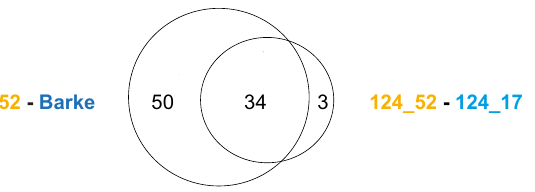
Fig. 4 The sibling lines harbouring contrasting alleles at locus QRMC-3HS and the cultivar Barke display distinct root transcriptional pro fi les. Venn diagram showing the number of differentially expressed genes among pairs of comparisons between the sibling lines 124_52 (wild-like), 124_17 (elite- like) and their elite parent Barke (EdgeR pair-wise comparison, individual P -values < 0.01, FDR corrected). Source data are provided as a Source data fi le.